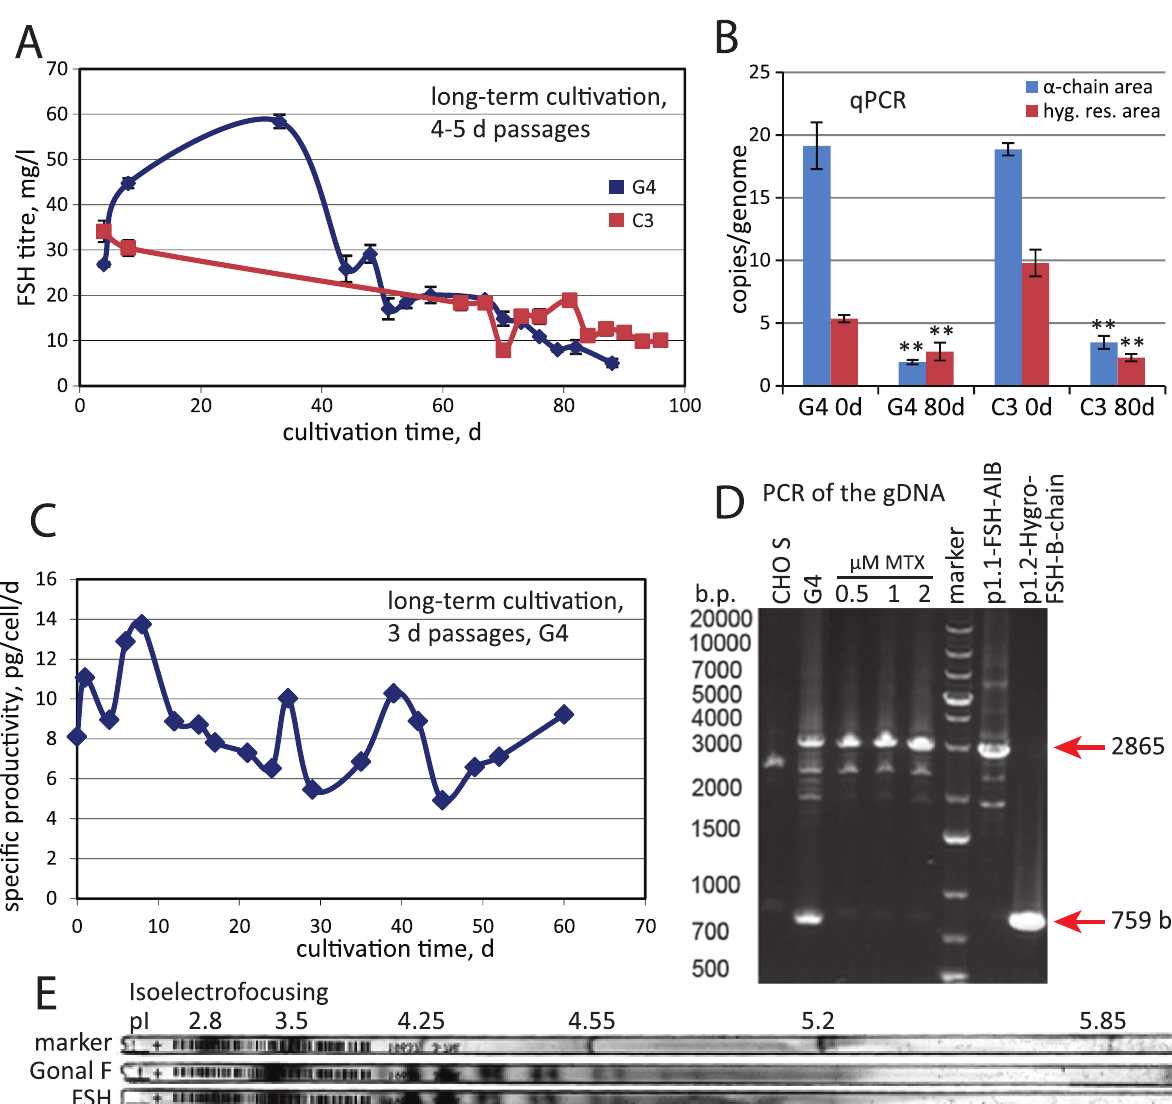
Fig 3. The long-term secretion rate dynamics, genetic stability of the selected clonal cell line and hormone isoforms distribution of the purified FSH. A—FSH titre dynamics for the long-term cultivation of the G4 and C3 clonal cell lines, 4–5 days passages by ELISA, n = 2. B—qPCR analysis of the expression cassette copy numbers per haploid genome for clonal lines after long-term cultivation. “hyg. res. area”—Hygromycin B resistance gene area, primer pair RT-HYG-F—RT-HYG-R. Error bars represent standard deviation, n = 3. 0d –the first day of cultivation, 80d –samples taken after the 80 days of cultivation. C—Dynamics of the specific productivity of the G4 cell line during long-term cultivation, 3 days passages. D—PCR analysis of the G4 cell line genomic DNA, primers pair SQ-5CH6-F—SQ-3CH1-R. Expected products sizes are depicted by arrows, the image was contrast- enhanced to add visibility. E—Isoelectrofocusing analysis of the purified FSH. Samples were loaded in non-denaturing conditions.